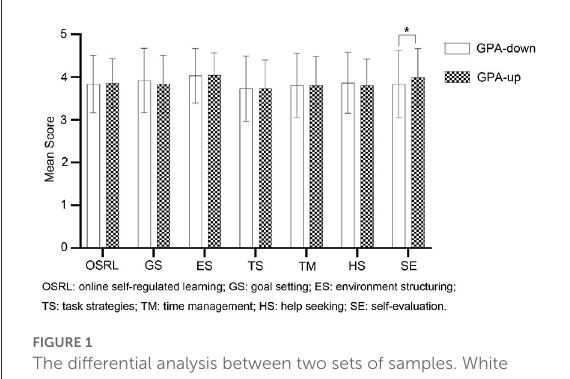
FIGURE2 Graphed scores of GPA-up and GPA-down students in the SRL strategies. White indicates GPA-down students, black points indicate GPA-up students, and stars represent significant differences between the two groups. No stars indicate no significant differences in SRL